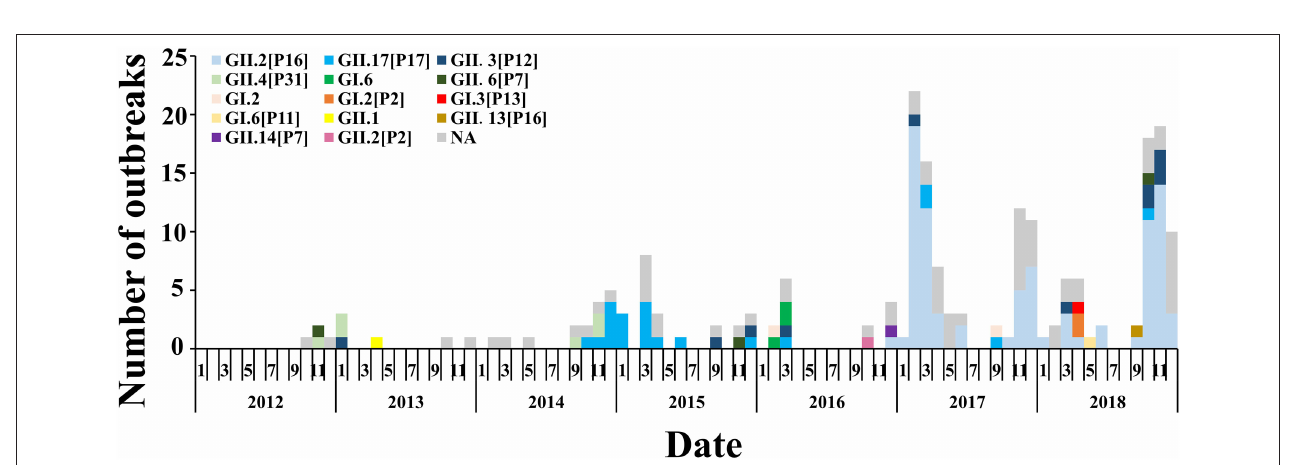
FIGURE 5 | Changes of norovirus genotypes in Jiangsu Province from 2012 to 2018.